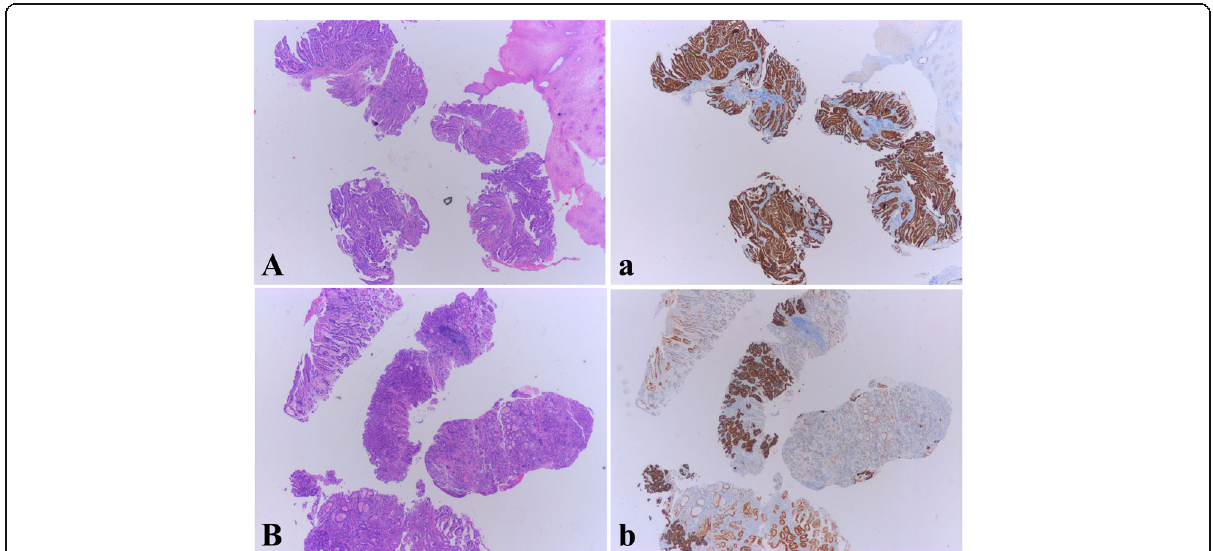
Fig. 1 Examples of Intratumoral homogeneity and heterogeneity of HER2 IHC staining in biopsy specimens. A The biopsy of an intestinal type GC shows 4 tumor-containing fragments in the 5 biopsy specimens. a HER2 IHC staining shows that all the 4 tumor fragments are uniformly 3+ (homogeneous). B Four tumor fragments are found in this biopsy of an intestinal type GC. b Within the 4 fragments, 3 are stained 3+, the 4 th fragment is stained 1+ (heterogeneous). In addition, within the 3 HER2 3+ fragments, one of them demonstrates focally positive